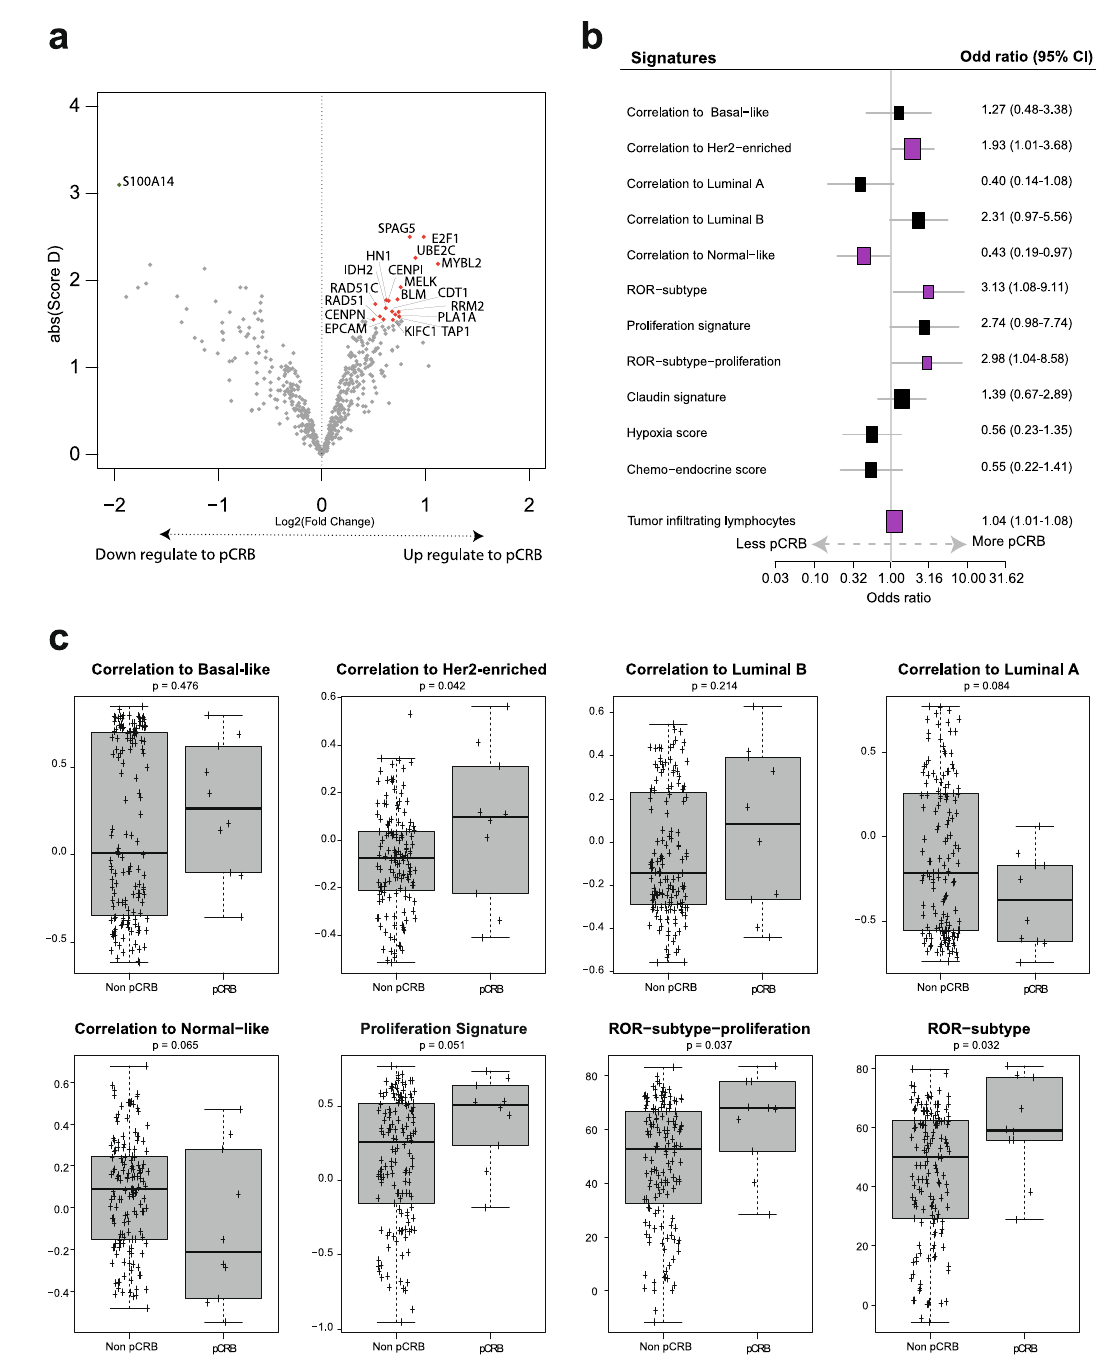
Fig. 3 Treatment activity based on baseline gene expression. a Genes found differentially expressed in baseline samples between pCR B and no-pCR B in SAM analysis. Colored dots mark the genes with a false discovery rate (FDR) = 0, in red upregulate and in green downregulated. b Association of 11 gene signatures (as a continuous variable) with pCR adjusted for cohort (TNBC and HR-positive). Each signature was evaluated as a continuous variable and was standardized to have a mean of 0 and a SD of 1. The size of the square is inversely proportional to the standard error; horizontal bars represent the 95% con fi dence intervals (CI) of Odd ratios. Statistically signi fi cant variables are shown in pink. c PAM50 signature expression at baseline according with pathologic complete response (pCR) or residual disease (non-pCR) at surgery. p -value was obtained after performing ANOVA test. Error bars correspond to standard error of the mean. between baseline TILs and age, nodal status, menopausal status varied statistically signi fi cantly according to the intrinsic subtype and tumor stage. TILs varied statistically signi fi cantly according to ( p < 0.001) (Supplementary Fig. 2c, d), with the higher levels of TILs the intrinsic subtype ( p < 0.001), with the Basal-like subtype in basal-like and HER2-enriched subtype. We evaluated the association of baseline TILs with pCR. High showing the highest score (median 10%), followed by the HER2- TILs were statistically signi fi cantly associated with pCR after enriched (5%), Luminal B (3%) Normal-like (3%) and Luminal A adjusting for HR status (OR = 1.04; 95% CI 1.01 – 1.08; p = 0.042) (2%) (Supplementary Fig. 2b). Across HR-positive tumors, TILs also Published in partnership with the Breast Cancer Research